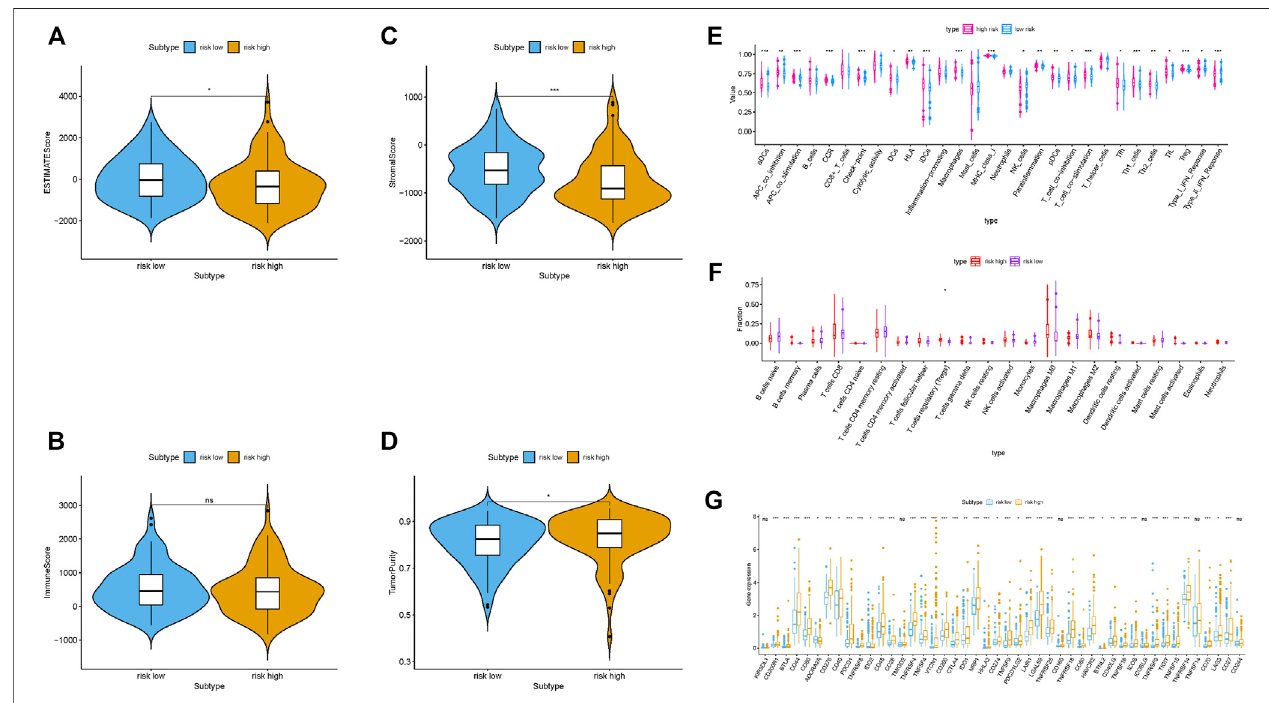
FIGURE4| CorrelationofprognosticriskscorewithTIMEcharacterizationofHCC (A – D) Comparisonofestimatescore,stromalscore,immunescore,andtumorpurity between these two subtypes. (E) Distinction of enrichment of immune-related signatures between low- and high-risk groups. (F) Difference of in fi ltrating immune cell subpopulationsandlevelsbetweenlow-/high-riskgroups. (G) Comparisonof46immunecheckpointblockade – relatedgenesexpressionlevelsintworiskscoresubgroups.